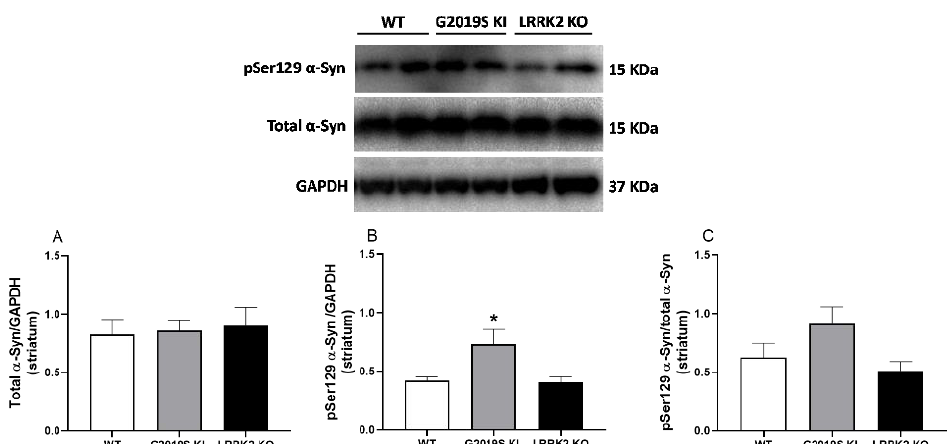
Figure 6. pSer129 α -synuclein levels are elevated in the striatum of 12-month-old G2019S KI mice. Western blot analysis of ( A ) total α -syn and ( B ) pSer129 α -syn levels in the striatum of 12-month-old G2019S KI and LRRK2 KO mice in comparison with age-matched WT controls. ( C ) pSer129 α -syn/total α -syn ratio is also shown. Data are expressed as mean ± SEM of n = 8 WT, n = 10 G2019S KI and n = 8 LRRK2 KO mice. Statistical analysis was performed using one-way ANOVA followed by the Tukey test for multiple comparisons. * p < 0.05, different from WT mice.